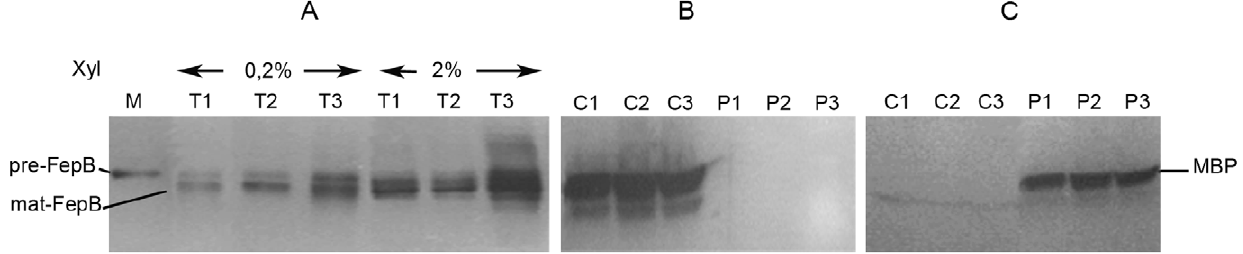
Figure 4. FepB production and cellular localization in strain SET 538 carrying various plasmids. A: FepB immunodetection in total cell pellets: SET 538 strains harboring pMD1-fepABC, pMD1-fepAB or pMD1-fepB were grown at 37 u C in M63 gly supplemented with xyl at two concentrations, 0.2 and 2% as indicated on the figure. Cells were harvested when they reached an OD 600 =1. M: FepB precursor proteins purified as inclusion bodies from strain JP313 pBAD24-fepB (the determined amino-terminal sequence was MTNYE); T1: total cell extract of strain SET 538 pMD1- fepABC; T2: total cell extract of strain SET 538 pMD1-fepAB; T3: total cell extract of strain SET 538 pMD1-fepB. Each lane was loaded with 0.5 OD 600 cell culture equivalent. B: FepB immunodetection in cytoplasmic and periplasmic fractions: SET 538 strains harboring pMD1-fepABC, pMD1-fepAB or pMD1-fepB were grown in M63 gly supplemented with xyl at 2% for the first two strains and 0.2% concentration for the last strain. Cells were harvested when they reached OD 600 =1. C1: cytoplasmic fraction of strain SET 538 pMD1-fepABC; C2: cytoplasmic fraction of strain SET 538 pMD1- fepAB; C3: cytoplasmic fraction of strain SET 538 pMD1-fepB. P1: periplasmic fraction of strain SET 538 pMD1-fepABC; P2: periplasmic fraction of strain SET 538 pMD1-fepAB; P3: periplasmic fraction of strain SET 538 pMD1-fepB. FepB is not immunodetected in P1, P2 or P3 periplasmic fractions. Each lane was loaded with 0.5 OD 600 cell culture equivalent. C: MBP immunodetection in cytoplasmic and periplasmic fractions: The same cytoplasmic (C1, C2, C3) and periplasmic fractions (P1, P2, P3) were immunodetected with anti-MBP antibodies. Each lane was loaded with 0.5 OD 600 cell culture equivalent. MBP was not immunodetected in C1, C2 or C3 cytoplasmic fractions, but in P1, P2 and P3 periplasmic fractions of the 3 strains.